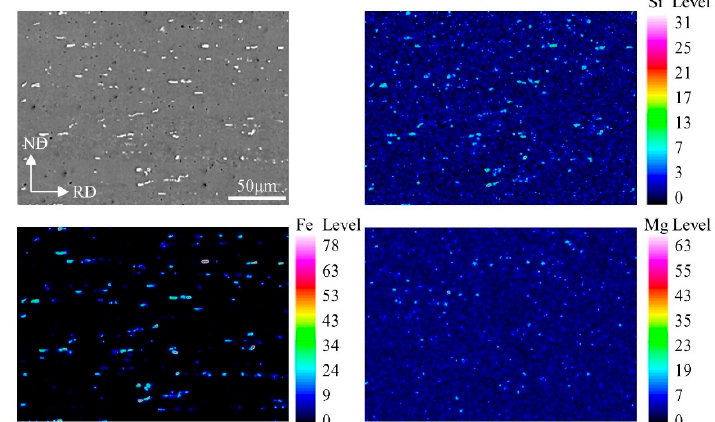
Figure 12. SEM image of alloy element distribution in VHR sample.